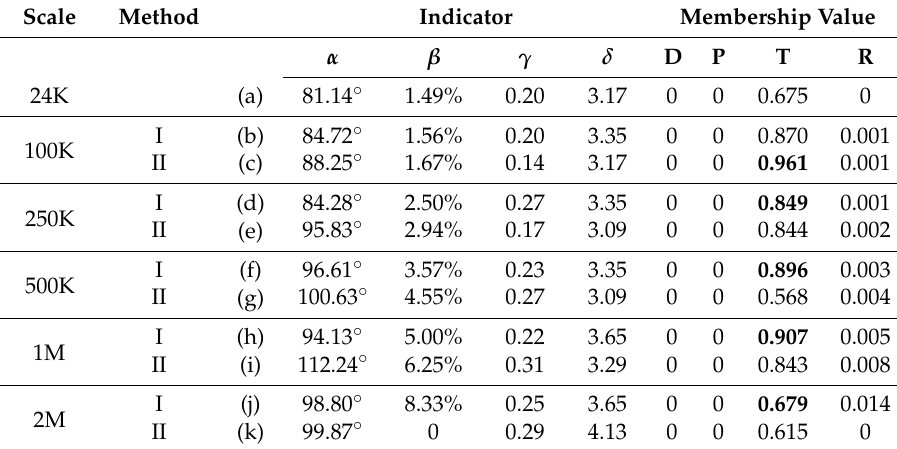
Table 9. Assessment result of trellis case at different